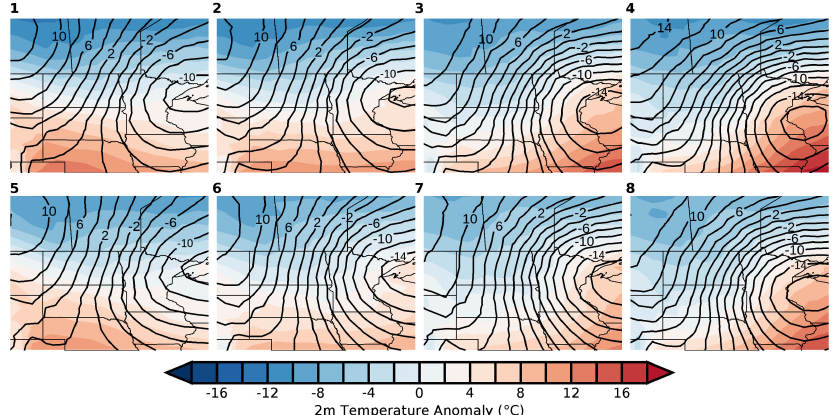
Figure 9. MSLP (hPa, dashed lines) and surface temperature ( ◦ C, filled contours) anomalies during the midpoint of blizzards for the eight-class (2 × 4) SOM. Nodes are identified by the external numbers ranging from 1–4 (5–8) for the top (bottom) rows.